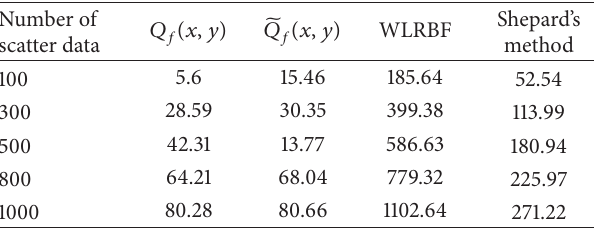
Table 4: The computing time of the four methods on the 50 × 50 grid points in the unit square. Number